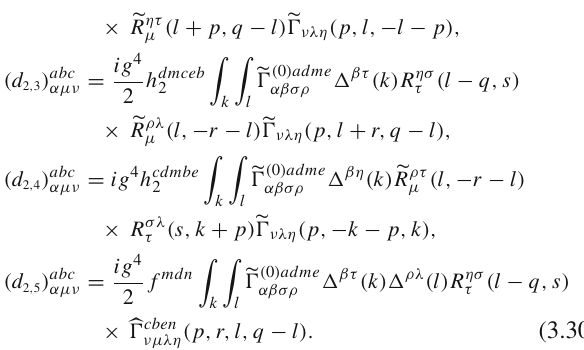
),( d ),( d ),( d ),( d ) } 2 , 1 2 , 2 2 , 3 2 , 4 2 , 5